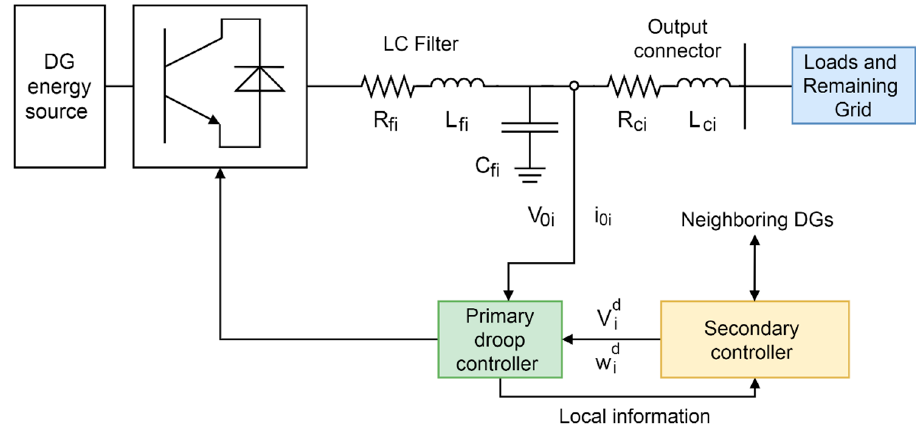
Figure 2. Diagram of inverter-based distributed generation (DG).